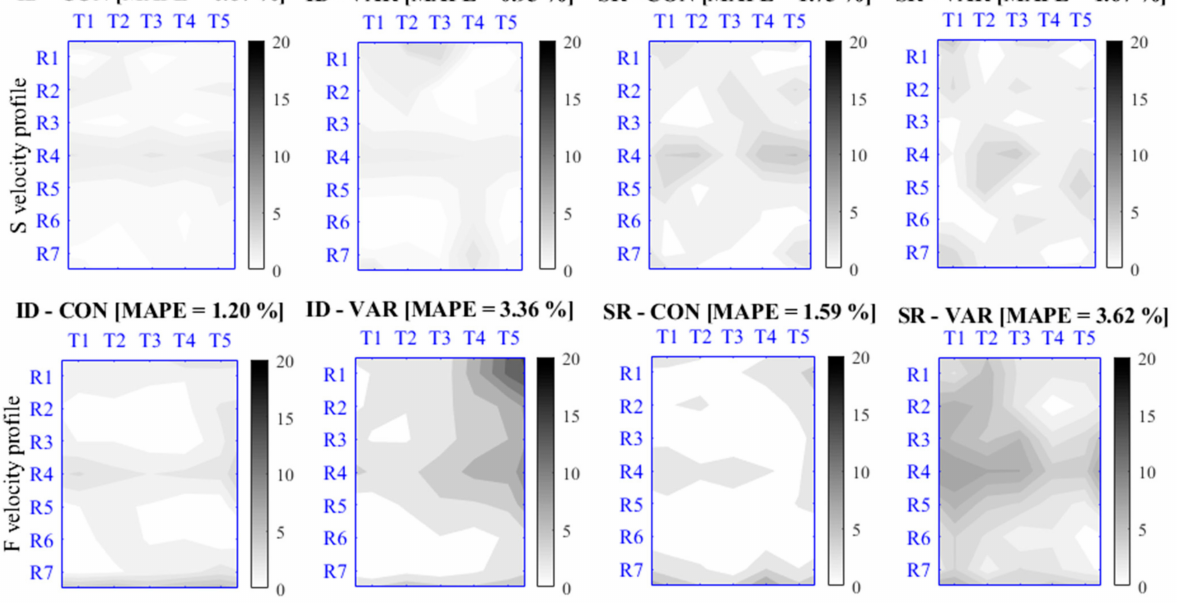
Figure 8. Maps of APE i for 8 representative cases (median case in terms of MAPE ) of the scenarios (first set of simulations: frame-rate = 4 fps, d = 30 s) with the MD seeding density for both slow (S–top graphs) and fast (F–bottom graphs) velocity profile, under all the 4 possible environmental condition-tracer size schemes, i.e., from the left to the right: ID-CON ( ideal and constant size ), ID-VAR ( ideal and variable size ), SR-CON ( semi-real and constant size ), SR-VAR ( semi-real and constant size